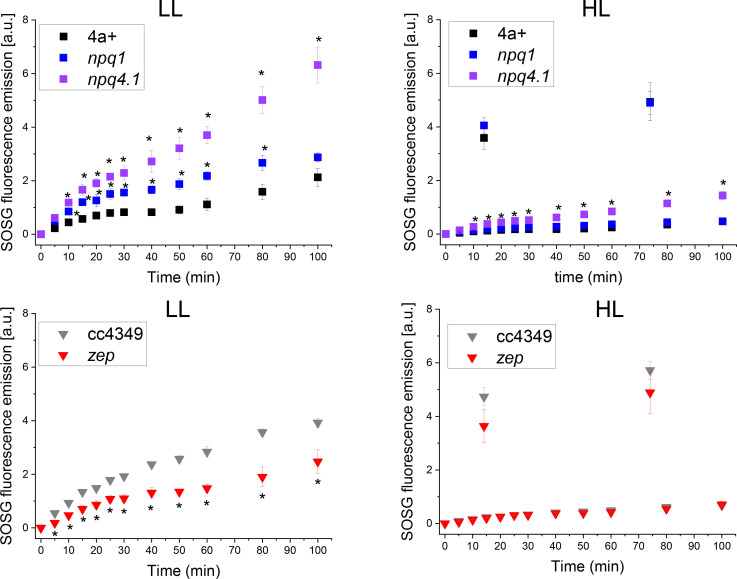
SOSG fluorescence emission kinetics in WT and mutant strains.Singlet oxygen production was measured via the singlet oxygen sensor green (SOSG) fluorescence probe. Low-light (LL) or high-light (HL) acclimated samples were exposed to strong red light (2000 μmol m−2s−1) and singlet oxygen production rate was probed at the different time points by following SOSG fluorescence at 530 nm. Genotypes having the same background are shown in the same Panel. The results reported are representative of three independent biological replicates for each genotype in LL or HL. Error bars are reported as standard deviation (N = 3). The statistical significance of differences compared to WT (4A+ for npq1 and npq1 lhcsr1 mutants, CC4349 for zep mutant) is indicated as * (p<0.05), as determined by unpaired two sample t-test (N = 3).